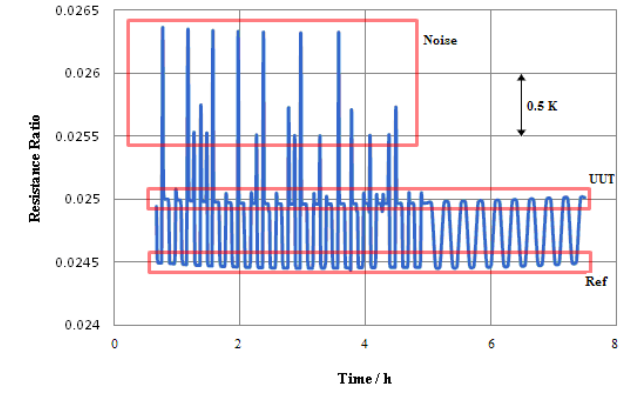
Fig. 2. Controlled temperature near the triple point of O 2